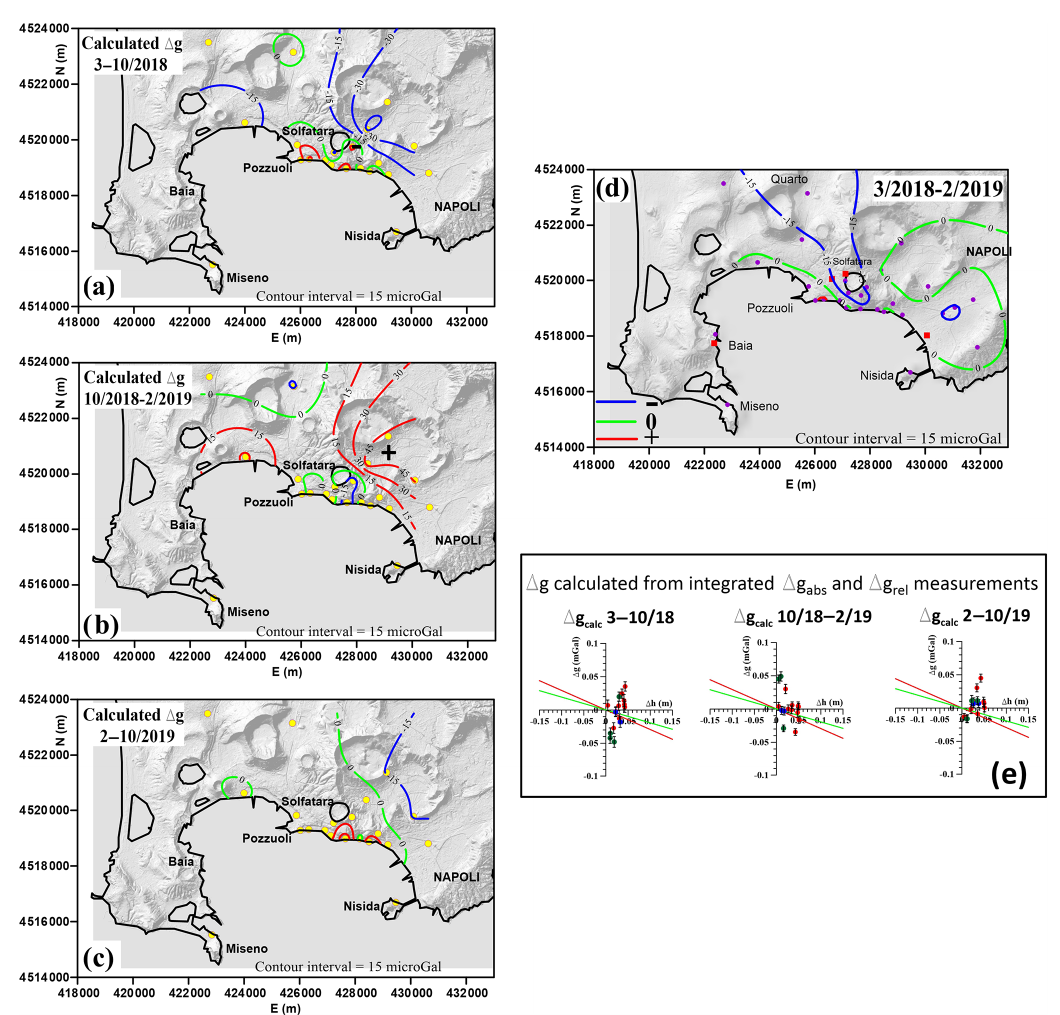
Figure 4. Calculated gravity field integrating relative and absolute gravity changes and the related (cid:49)g/(cid:49)h regression over the period March 2018–October 2019 are represented. In the (cid:49)g/(cid:49)h diagrams in (e) the errors on (cid:49)g are also represented; the error on (cid:49)h is contained in the size of the